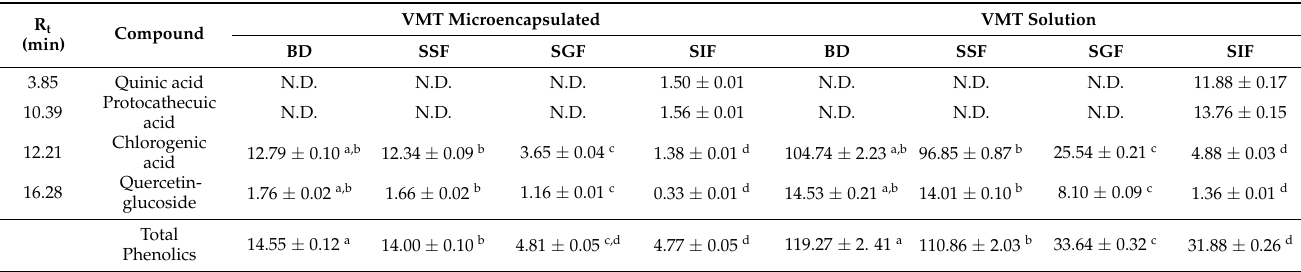
Table 3. Effect of salivary, gastric, and intestinal in vitro digestion on the phenolic content of VMT mg/g.